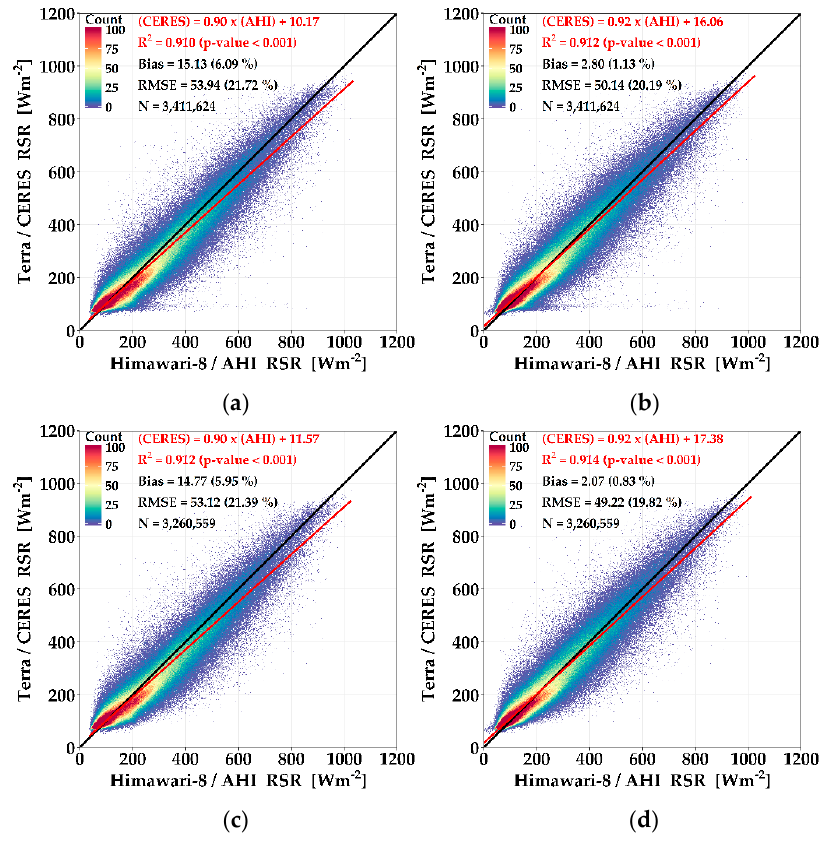
Figure 5. Two-dimensional histograms of RSR from Himawari-8/AHI and Terra/CERES for: OLD ( a ) OLD2 (+ anisotropy) ( b ); OLD3 (+ sun glint (SG) ≥ 20 ◦ ) ( c ); and NEW (+ anisotropy, sun glint (SG) ≥ 20 ◦ ) ( d ) on the 15th day of every month from July 2015 to February 2017. The colors represent the 2D histogram (or density) of coincident pairs using a bin size of 1. The solid red line is a linear fit to the data. The black line corresponds to the 1:1